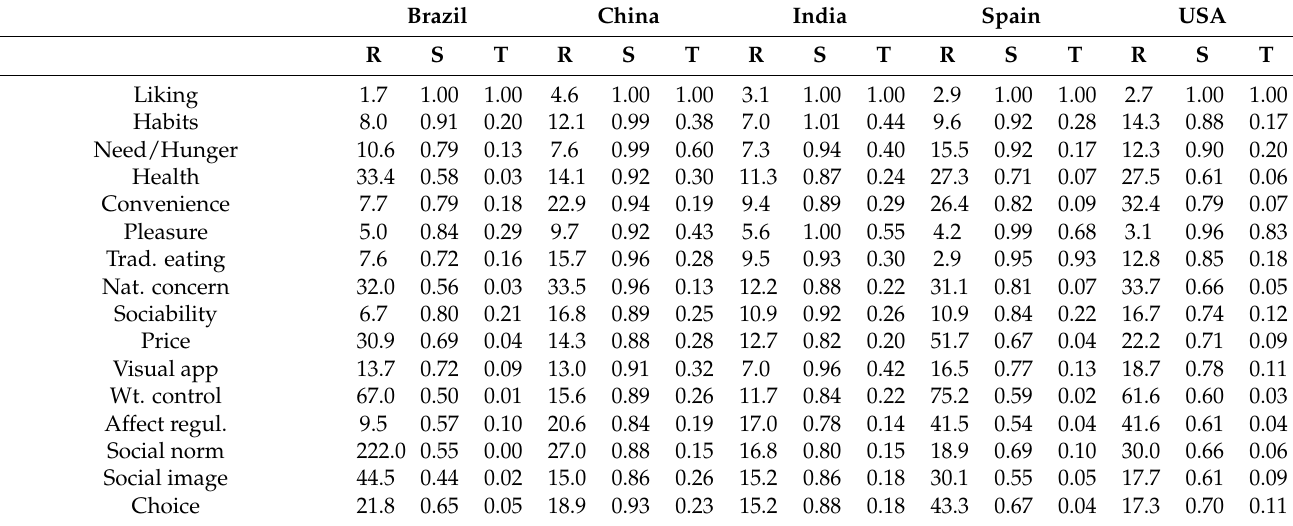
Table A8. Ratios of RATING “apply” responses to RATA “apply” responses (R) and standard indices of importance for RATING (S) and RATA (T) “apply” responses for each motivation construct to the liking motivation construct for dessert foods in all five